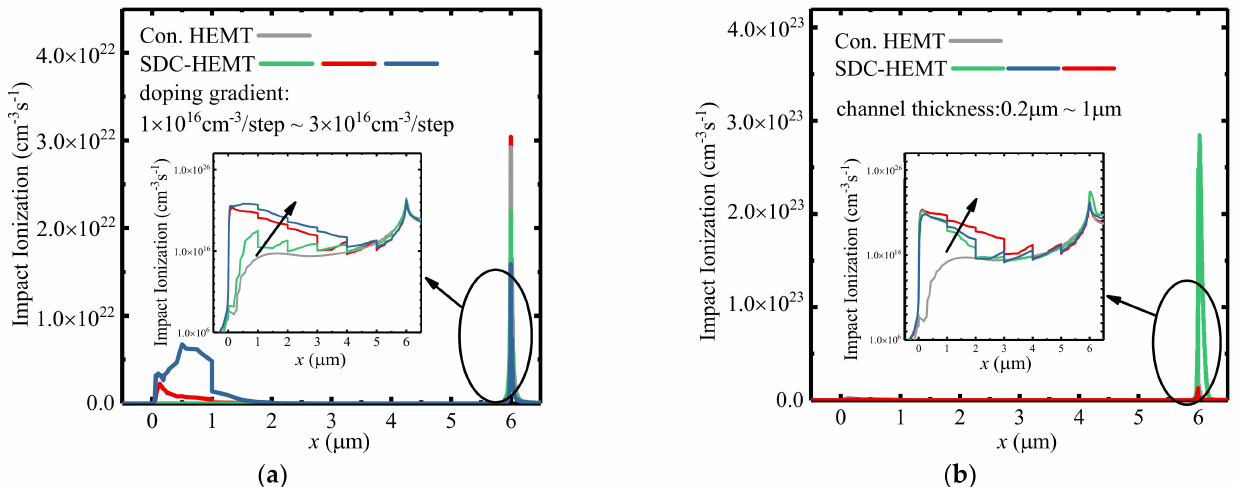
Figure 3. The impact ionization rate distribution at the heterojunction interface of the SDC–HEMTs with ( a ) different doping gradients (the channel thicknesses of SDC–HEMTs are 1 µ m) and ( b ) different channel thicknesses (the doping gradients of the SDC–HEMTs are 2 × 10 16 cm − 3 /step) when the breakdown occurs. The channel thickness of the conventional HEMT is 1 µ